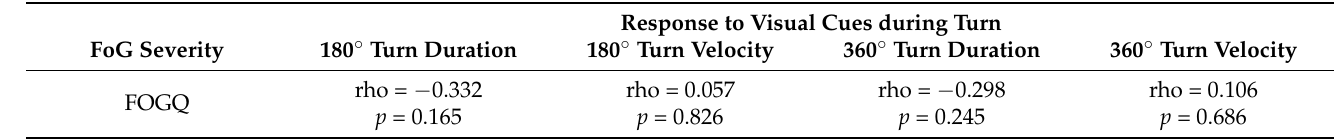
Table A1. Correlational analysis between FoG severity and response to visual cues during turning in